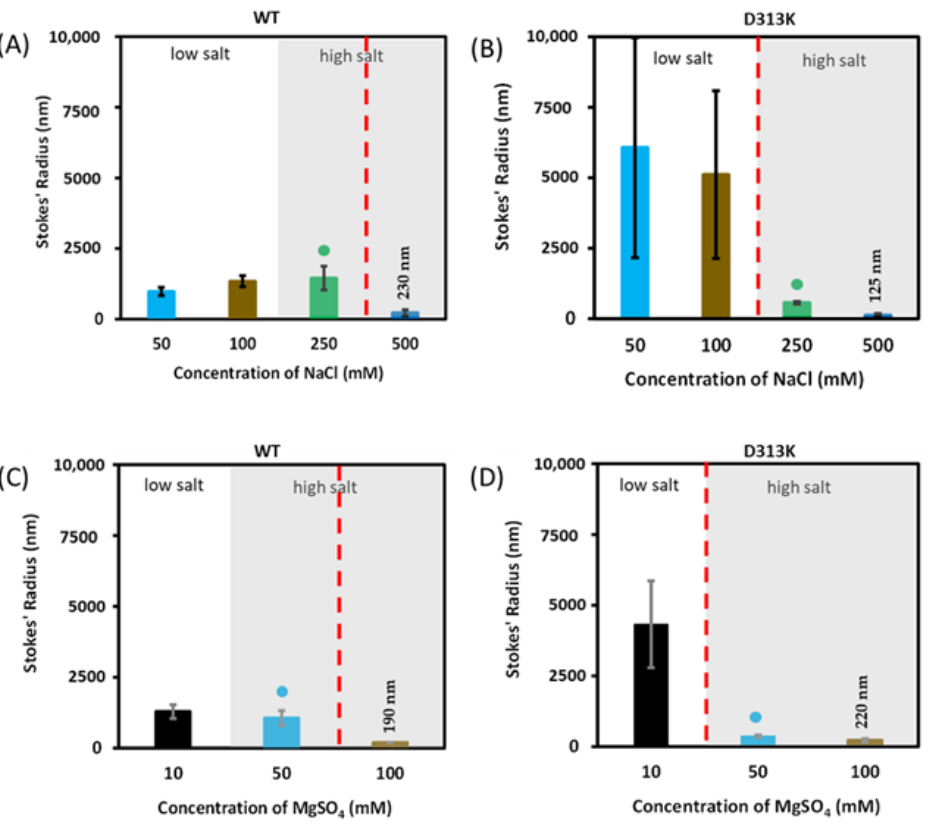
Figure 3. Hydrodynamic size of cl-Par-4 as a function of cation concentration for ( A ) WT with Na + [39]; ( B ) D313K with Na + ; ( C ) WT with Mg 2+ [39]; and ( D ) D313K with Mg 2+ . All data were acquired at pH 7.0 and ambient temperature. High salt conditions are indicated by a shaded background. The demarcation line between large and small particles is indicated by a dashed red line. The intermediate salt concentrations (250 mM NaCl and 50 mM MgSO 4 ) for which the WT and mutant hydrodynamic radii differ the most are marked with a dot. The smallest hydrodynamic radii are at the highest salt concentration in each panel ( A – D ): 230 ± 10 nm, 125 ± 60 nm, 190 ± 5 nm, and 220 ± 60 nm, respectively.